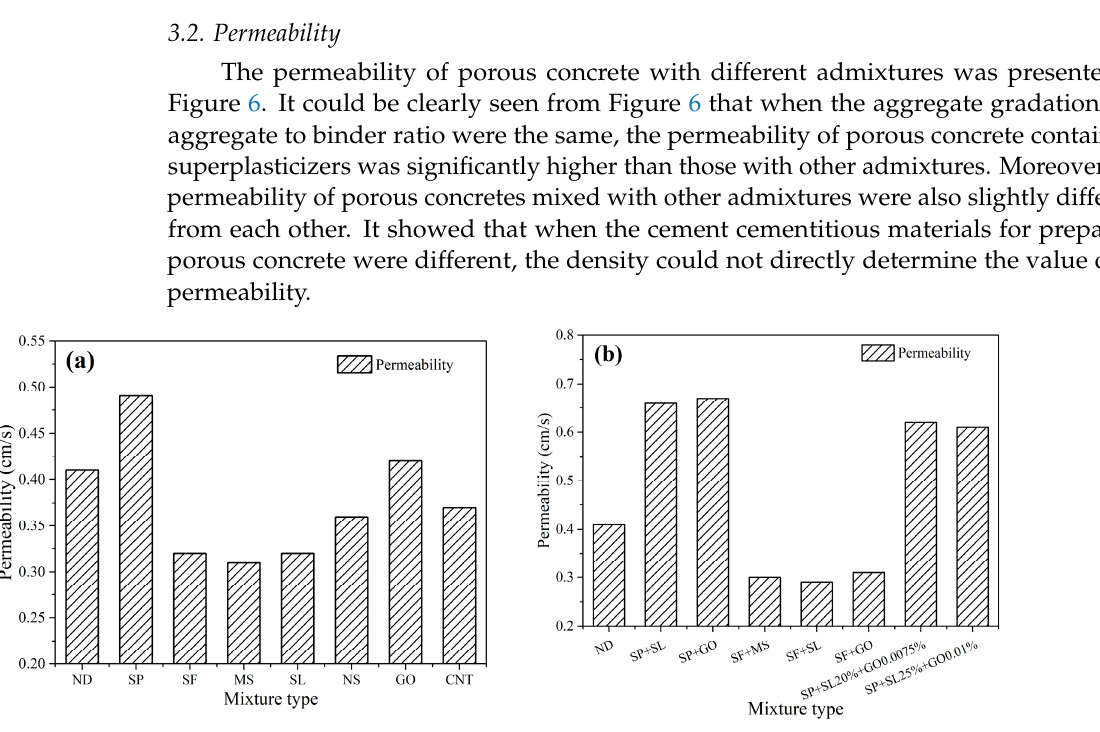
Figure 6. Permeability of porous concrete: ( a ) single admixtures; ( b ) composite admixtures.